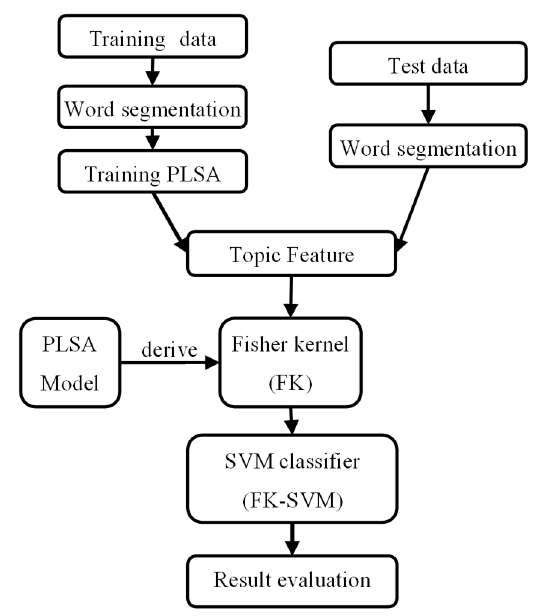
Figure 1. The flow chart of text sentiment analysis based on FK-SVM method.